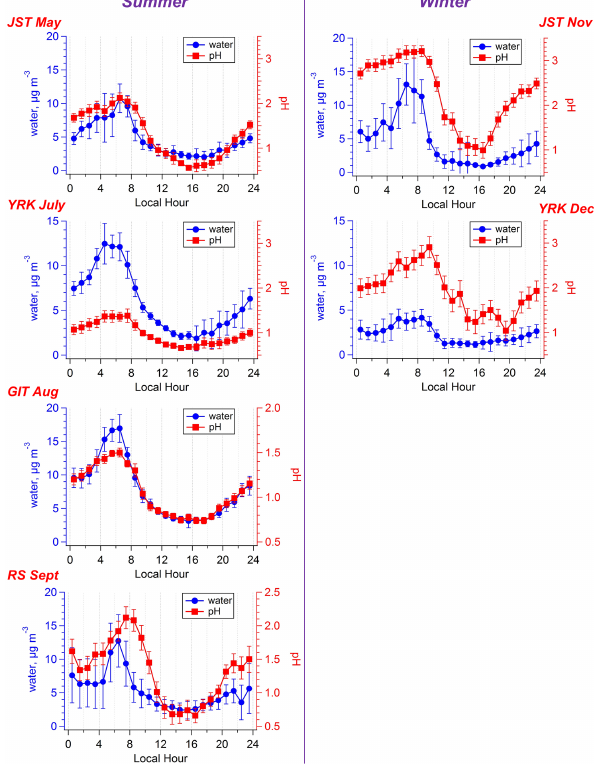
Figure 11. LWC and pH diurnal variation at SCAPE sites: com- parison between summer and winter. Median hourly averages and standard error bars at local hour are plotted. A bias correction of 1pH unit is applied due to not considering ammonia partitioning.